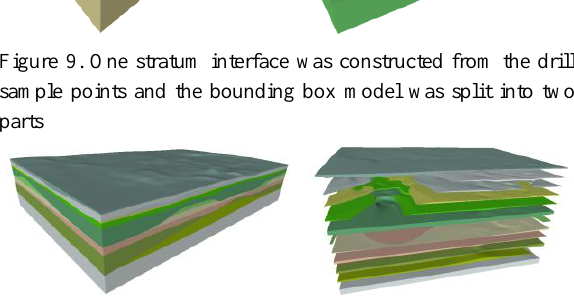
Figure 10. The stratum models were constructed after series of interface splitting from bounding